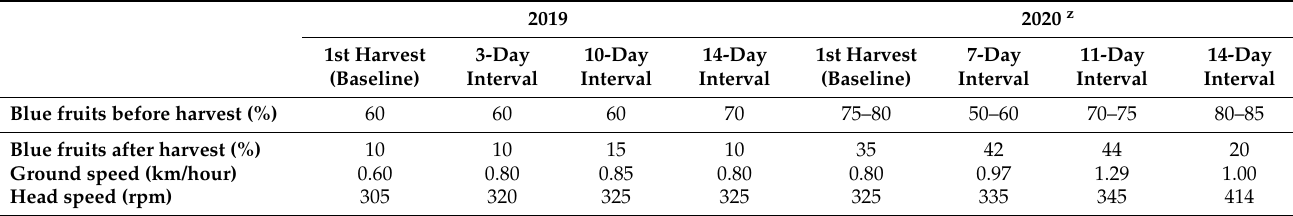
Table 1. Percent blue fruit visually estimated on bushes before and after harvest and ground and head speeds of a modified over-the-row (OTR) harvester used to harvest ‘Liberty’ northern highbush blueberry at different harvest intervals in northwest Washington, USA,